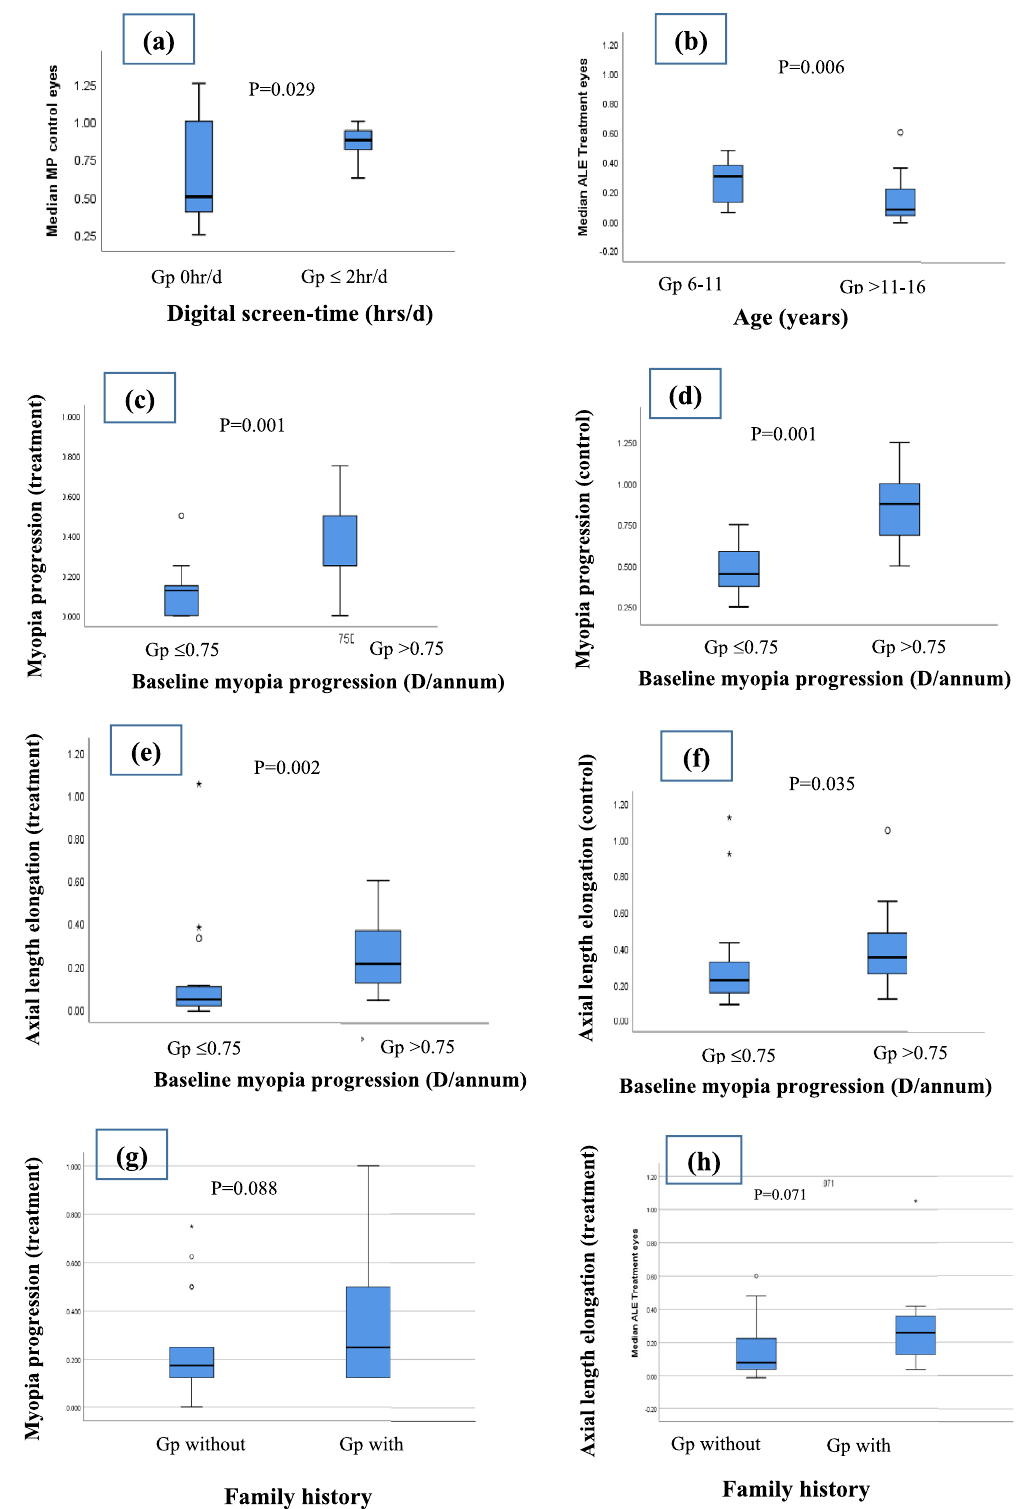
Figure 2. Box-whisker-plots showing the difference of MP or ALE between sub-groups: ( a ) MP (control eyes) in children not using digital device vs children with screen time upto 2 h/day ( b ) ALE (treatment eyes) in children 6–11 years vs > 11–16 years; ( c ) MP (treatment eyes) in children with BMP ≤ 0.75 D/annum versus BMP > 0.75 D/annum; ( d ) MP (control eyes) in children with BMP ≤ 0.75 D/annum versus BMP > 0.75D/annum; ( e ) ALE (treatment eyes) in children with baseline myopia progression ≤ 0.75 D/ annum vs > 0.75 D/annum; ( f ) ALE (control eyes) in children with baseline myopia progression ≤ 0.75 D/annum vs > 0.75 D/annum; ( g ) MP (treatment eyes) in children without and with family history; ( h ) ALE (treatment eyes) in children without and with family history. ( H/d hours/day, MP myopia progression, ALE axial length elongation, D/annum Dioptre per annum, BMP baseline myopia